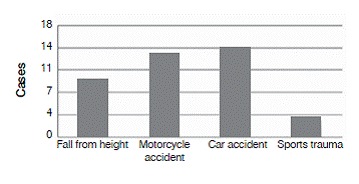
Injury mechanism.